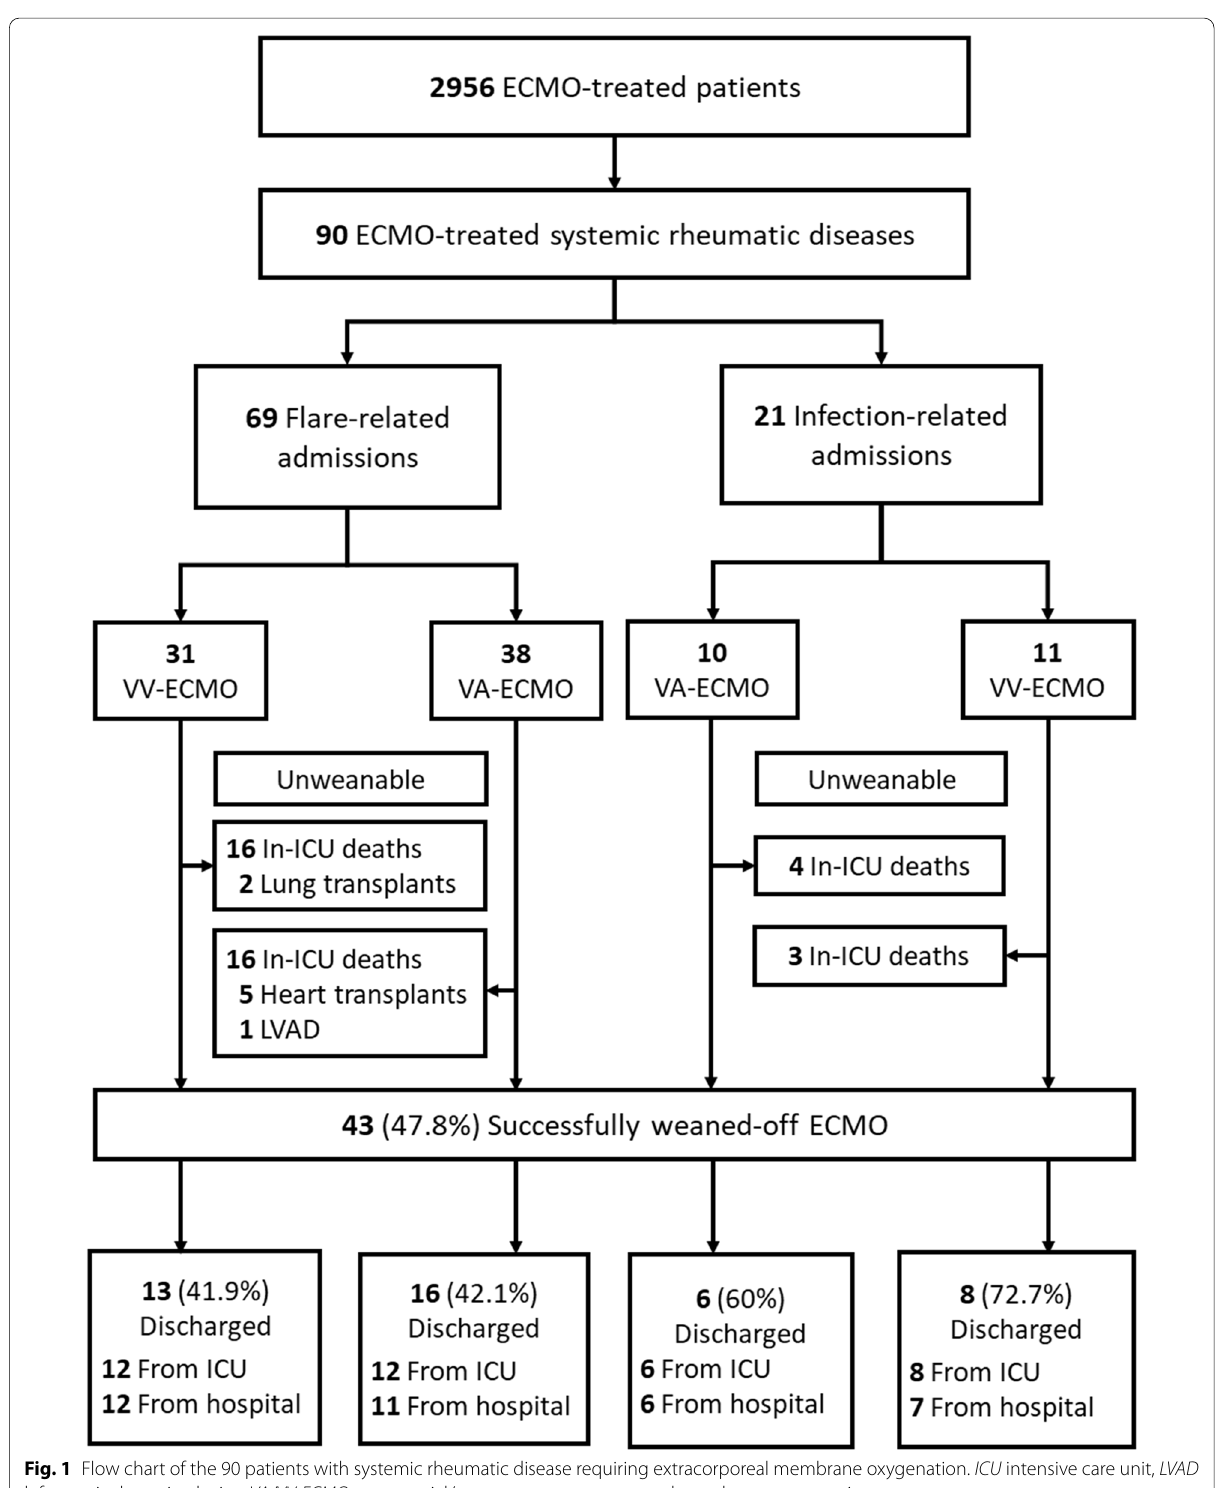
Fig. 1 Flow chart of the 90 patients with systemic rheumatic disease requiring extracorporeal membrane oxygenation. ICU intensive care unit, LVAD left ventricular assist device, VA/VV-ECMO venoarterial/venovenous‑extracorporeal membrane